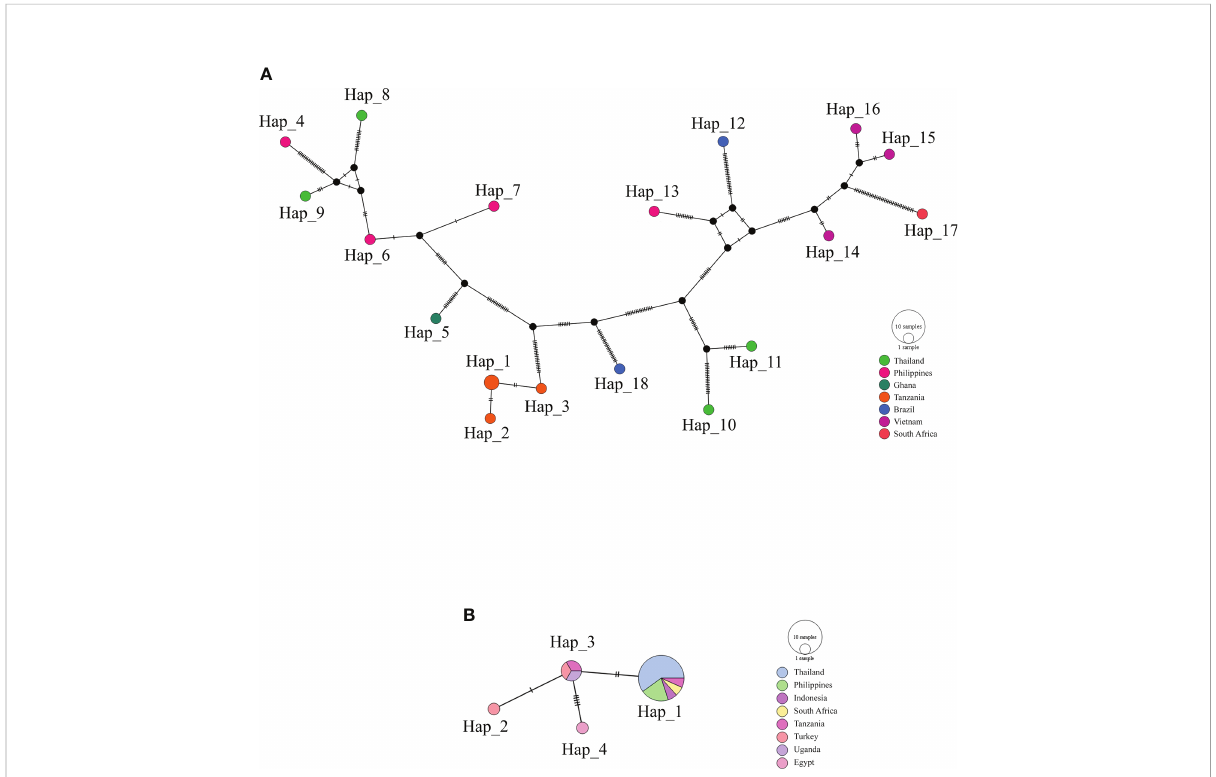
FIGURE 2 TCS network of haplotypes based on the B bovis sbp-2 (A) and B bigemina rap-1a (B) gene sequences detected in Thailand and worldwide countries. Small traits between a haplotype and another stand for mutational occurrence. The black circles are the intermediated traits caused by the single nucleotide polymorphism